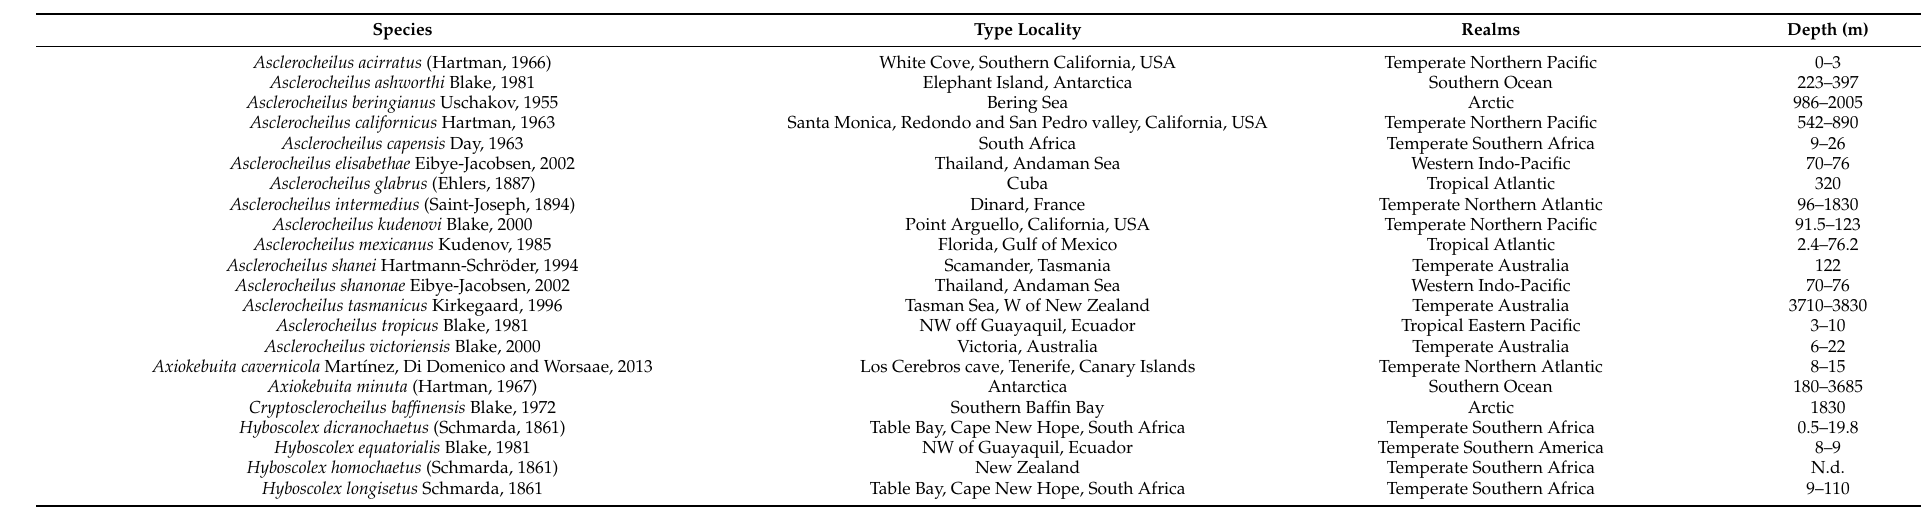
Table A2. List of valid species of Scalibregmatidae (after Blake [3,23]) with their type locality, realms sensu Spalding et al. [45] and depth ranges of type locality. N.d. = no data.